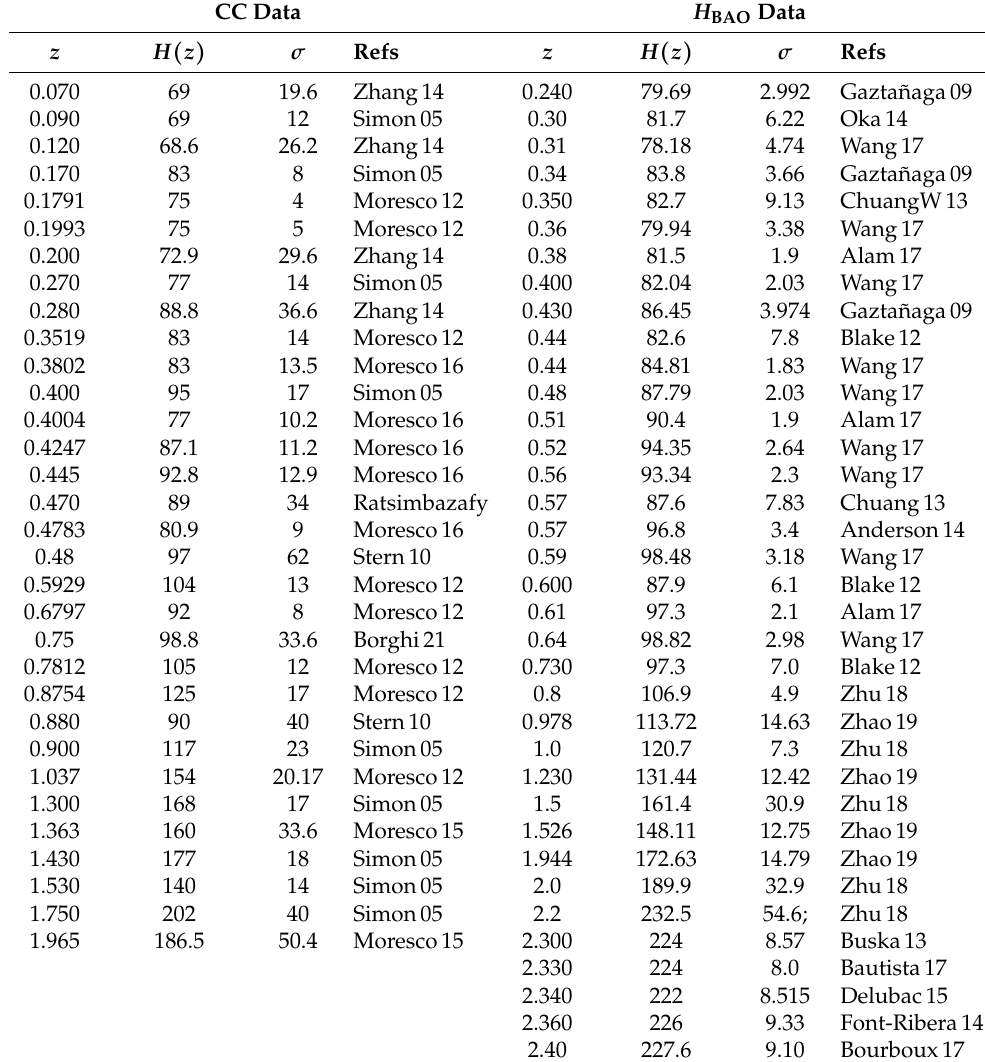
Table 1. H ( z ) data from cosmic chronometers (CC) [34–41] and line-of-sight BAO [44–58]. CC